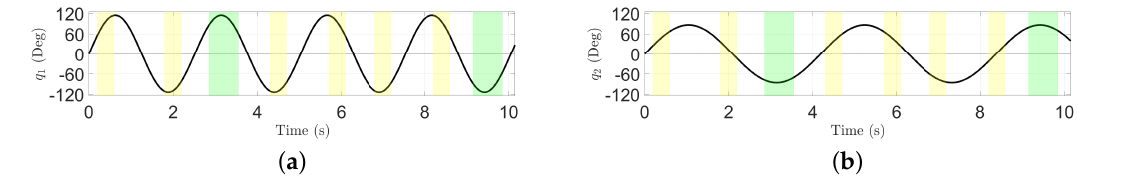
Figure 3. Command joint angle trajectories with sinusoidal signal: ( a ) Joint 1. ( b ) Joint 2.